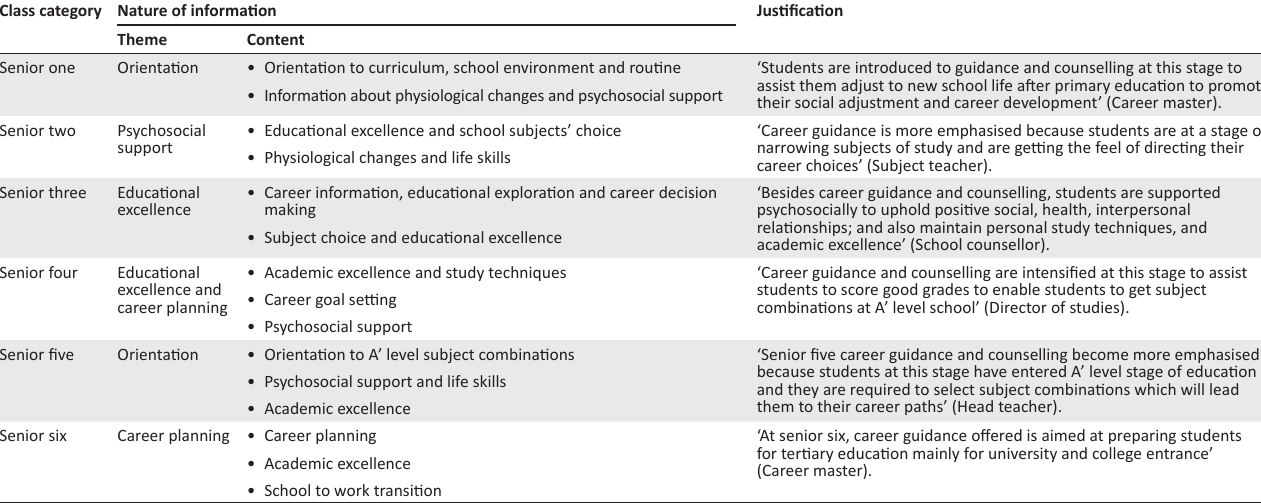
TABLE 2: Class category, nature of information and justification.